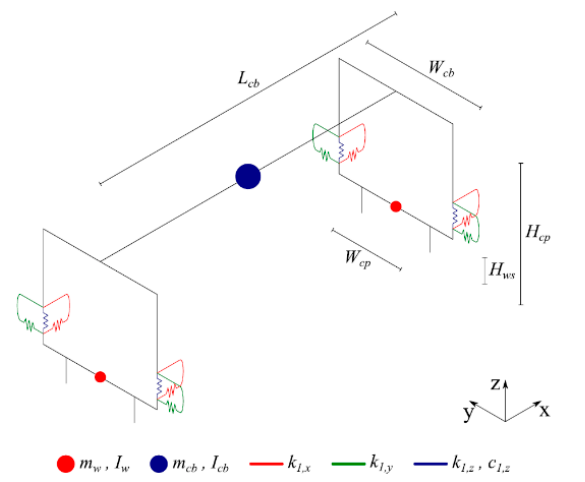
Figure 2. Wagon overview.